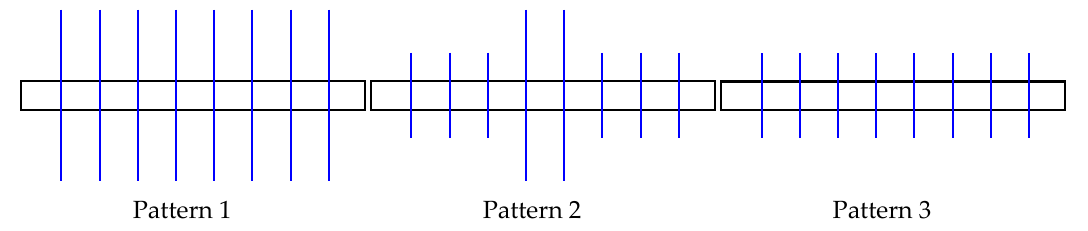
Figure 11. Schematic of different fracture length patterns.